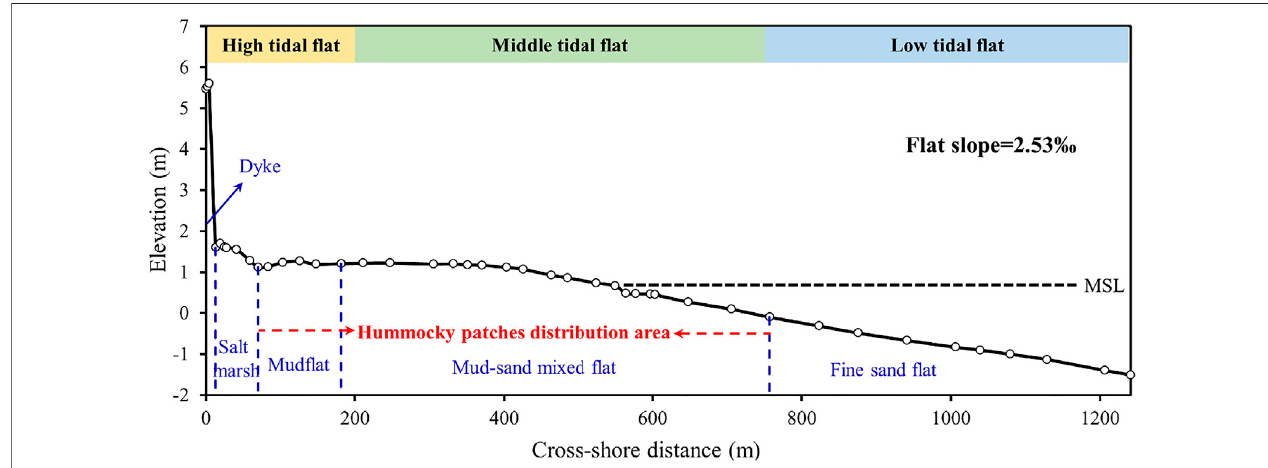
FIGURE5| Tidal fl atcross-sectionelevationpro fi leandslopebasedonmeasurementofRTK-GPS,showingfourdifferentsedimentaryzones(bluefont).Locations of hummocky patches are shown in red font. MSL, mean sea level.